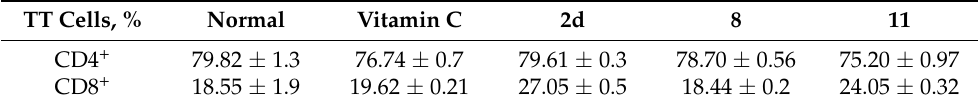
Table 9. Effect of the most promising three derivatives ( 2d , 8 , and 11 ) on the T lymphocyte population.